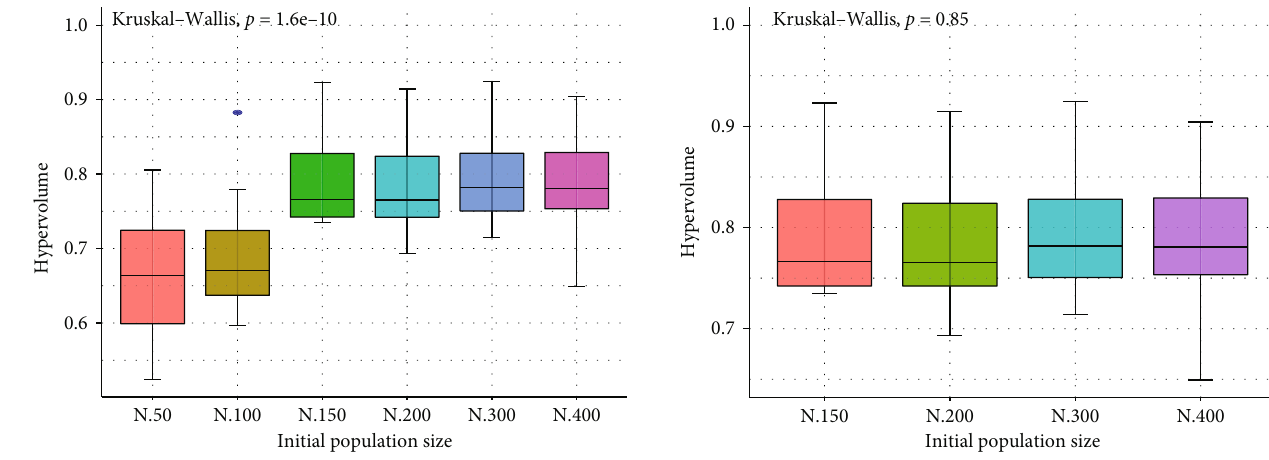
Figure 16: Comparison of six initial populations. Figure 17: Comparison of higher initial